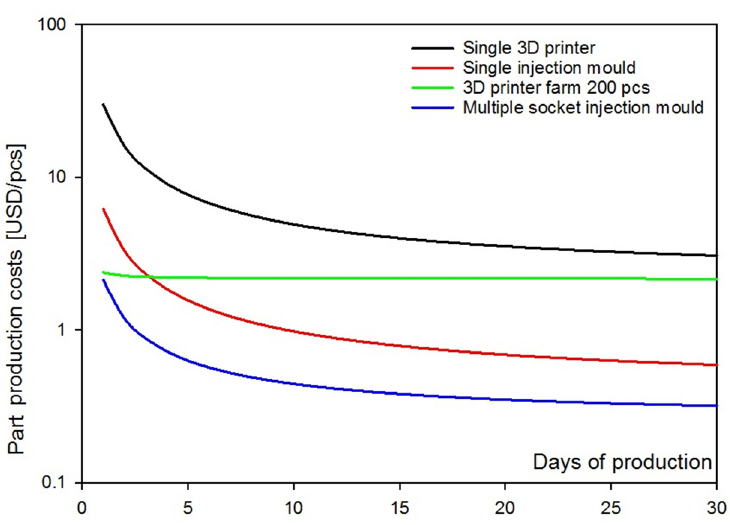
Figure 2. Comparison of unit production costs depending on the considered production period in days for various production techniques.